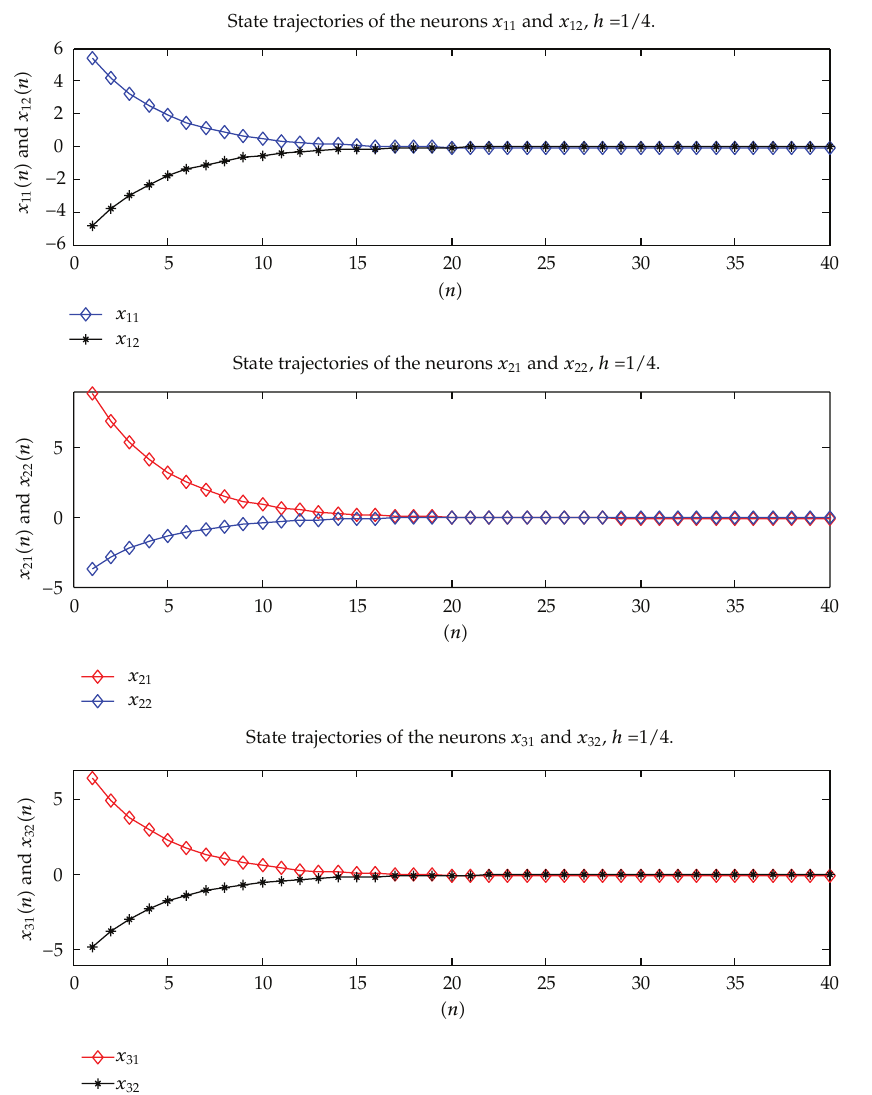
Figure 4: State trajectories of neurons x 11 , x 12 , x 21 , x 22 , x 31 , x 32 (cid:3) h (cid:8) 1 / 4 (cid:4)